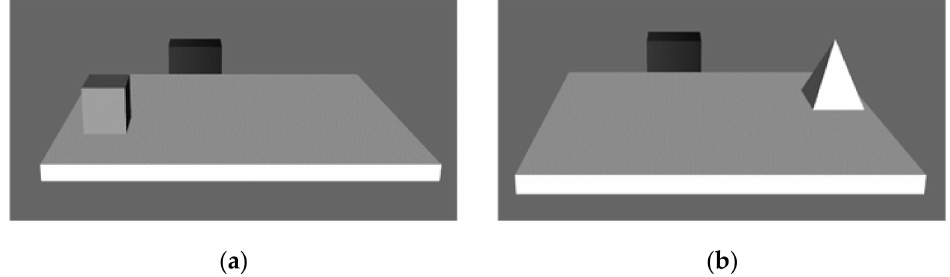
Figure 1. The figure shows an example of the two pictures that appeared in a trial, one after the other. ( a ) There is a cube closer to the participant than to the black bar. ( b ) There is a pyramid closer to the black bar than to the